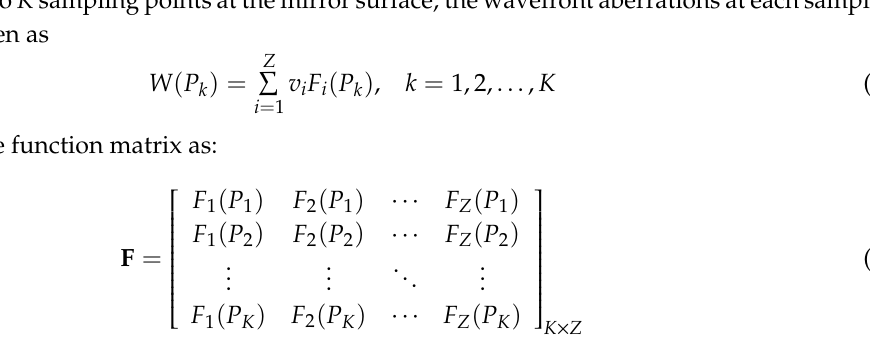
Figure 2. The arrangement of electromagnetic actuators of magnetic fluid deformable mirror